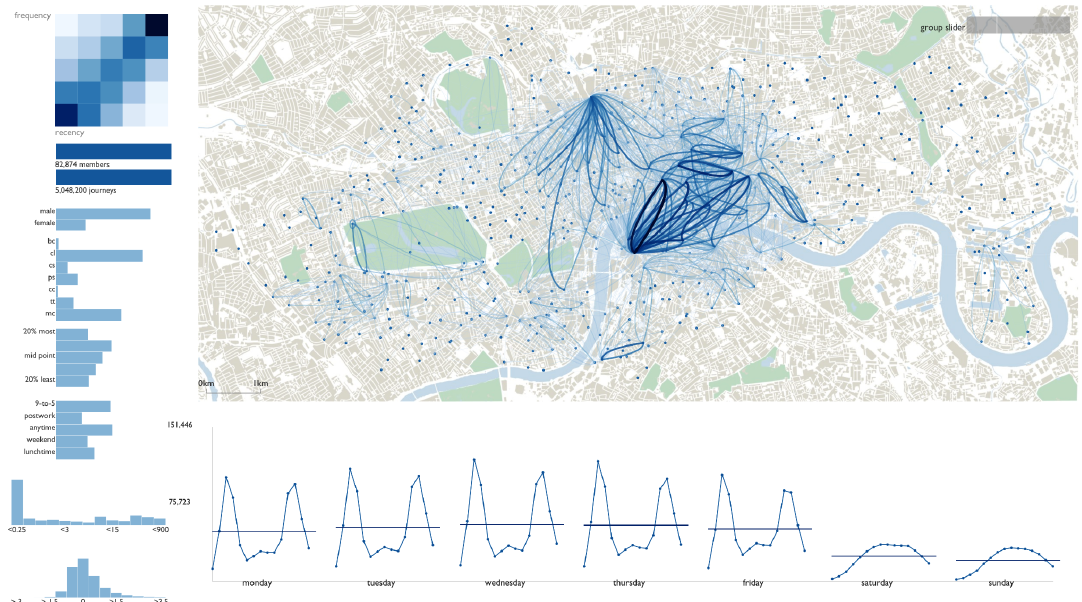
Figure 23. A visual analytics system for exploring cyclists’ trip patterns in London